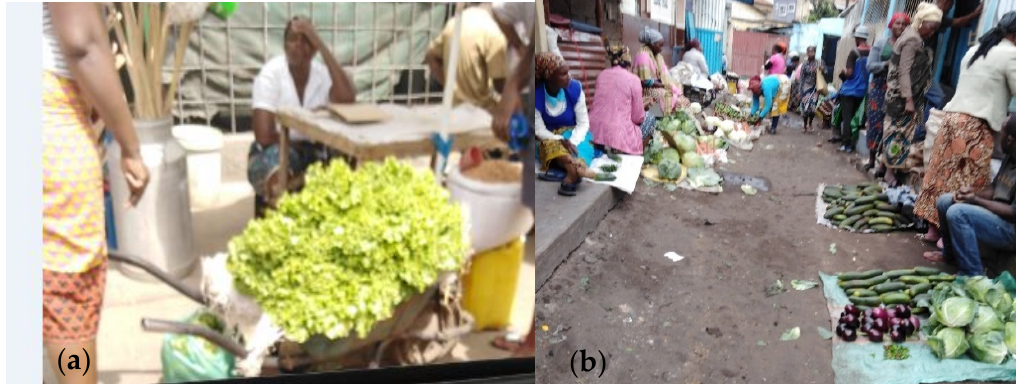
ra ffi a bags on the floor on Fajardo’s market.